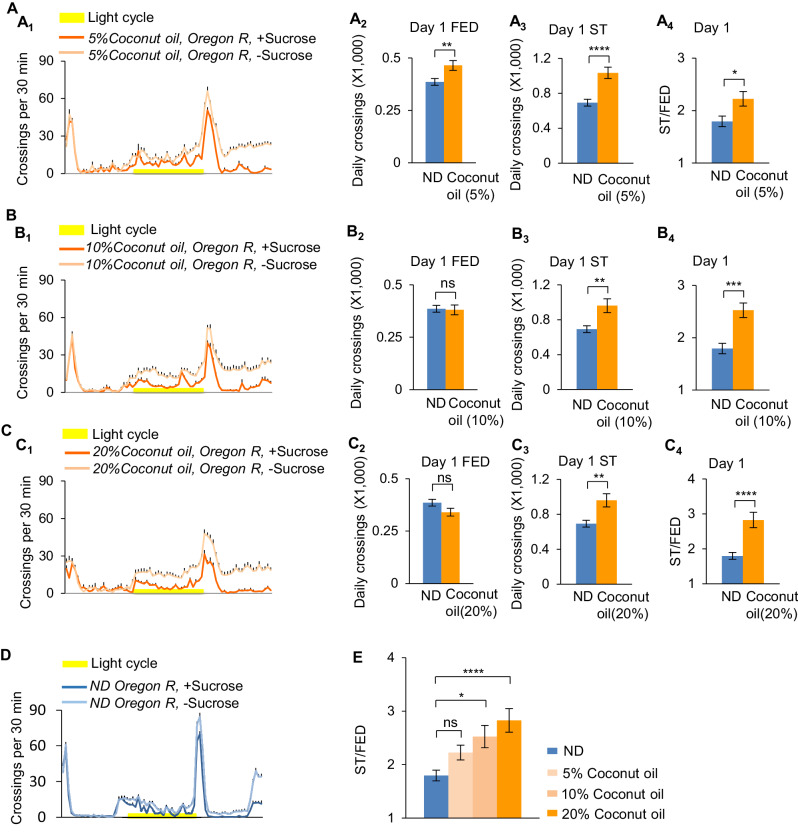
HFD promotes starvation-induced hyperactivity in a dose-dependent manner.Wild-type Oregon-R virgin female flies fed with normal fly food (ND, blue) or different concentrations of coconut oil (orange) were assayed in the presence (dark color) and absence (light color) of 5% sucrose using DAMS-based locomotion assay (n = 52–63). Midline crossing activities of indicated flies are shown in A1, B1, C1, and D. (A2, B2, C2) Average daily midline crossing activity of fed flies assayed in A1, B1, C1, and D. (A3, B3, C3) Average daily midline crossing activity of s;tarved flies assayed in A1, B1, C1, and D. (A4, B4, C4) Starvation-induced hyperactivity of flies assayed in A1, B1, C1, and D. (E) A summary of the effect of coconut oil feeding. ns, p>0.05; *p<0.05; **p<0.01; ***p<0.001; ****p<0.0001. Student’s t-test and one-way ANOVA followed by post hoc test with Bonferroni correction were used for pair-wise and multiple comparisons, respectively.